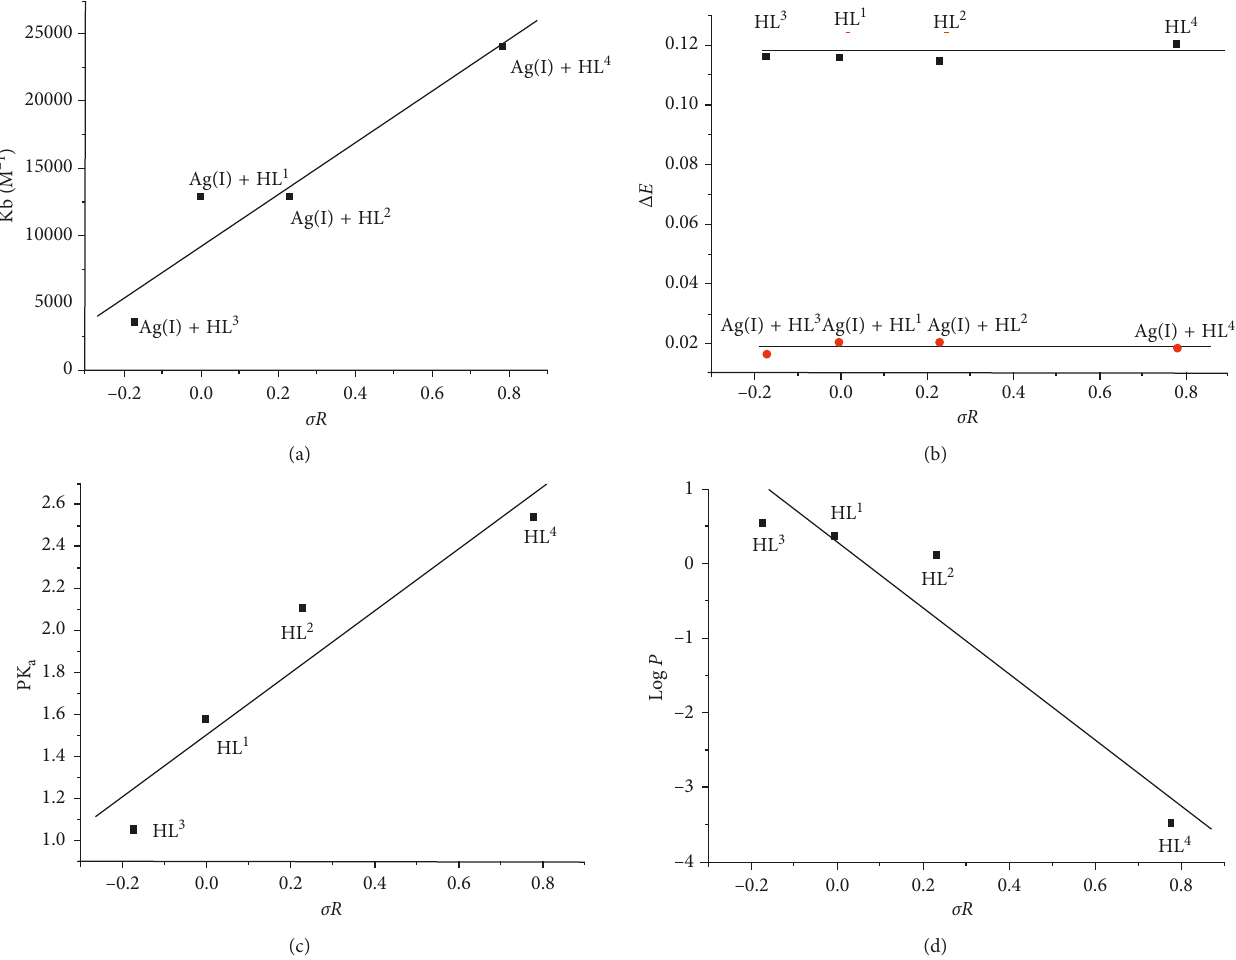
Figure 4: Hammett’s relation between effect of p -substituent ( σR ) versus constants ( K b ) of Ag(I)-HL 1–4